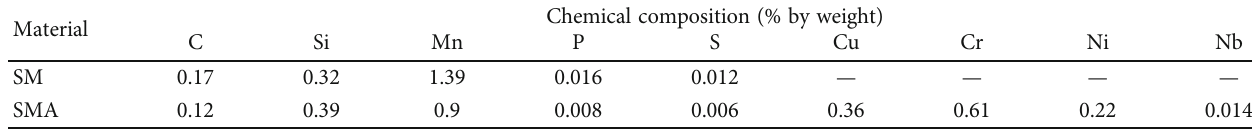
Table 1: Composition of carbon steel (SM) and weathering steel